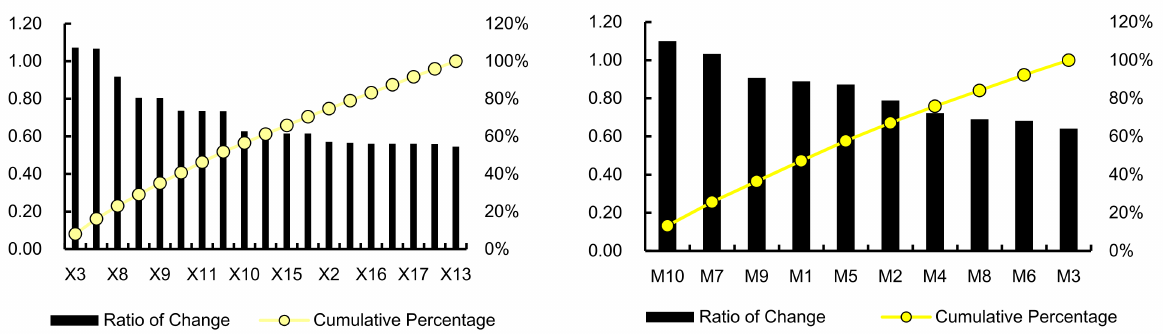
Figure 13. Identification of key human factors involved in